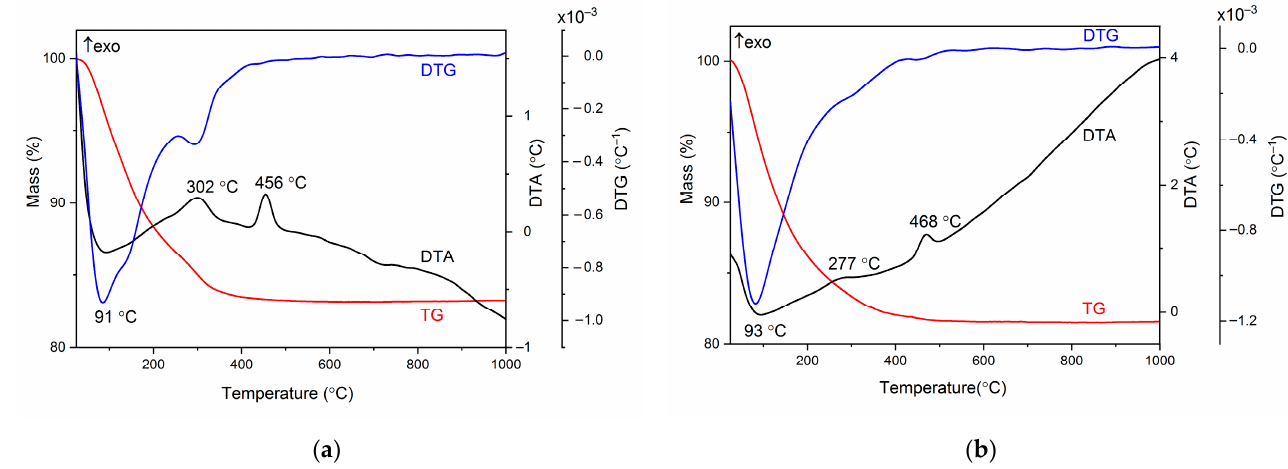
Figure 2. The TG (red)/DTG (blue)/DTA (black) curves of the ( a ) TiO 2 − Cu 2.0% MW sample and ( b ) TiO 2 − Zn 2.0% MW sample; heating rate was 10 °C/min, using air as carrier gas.